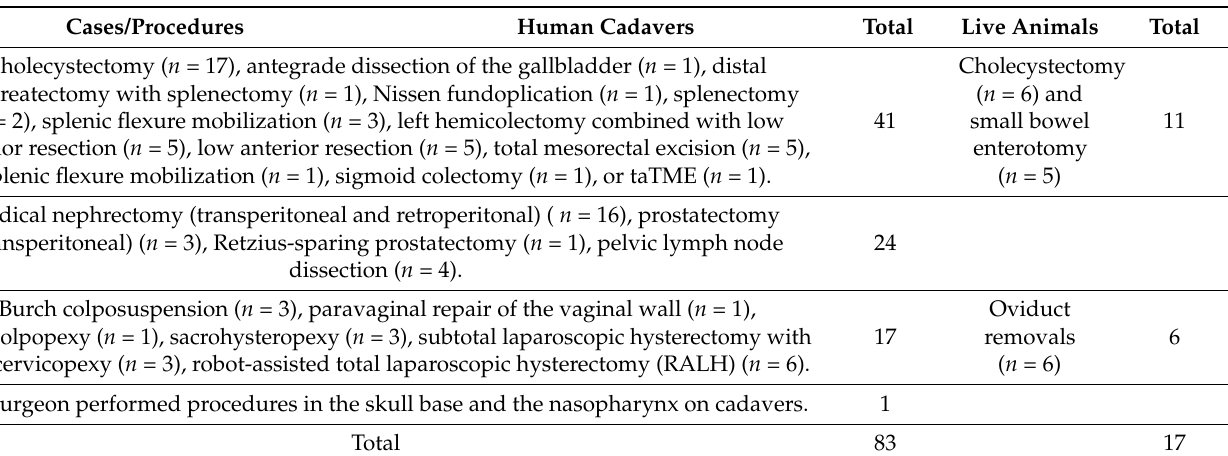
Table 3. Cases/procedures performed in